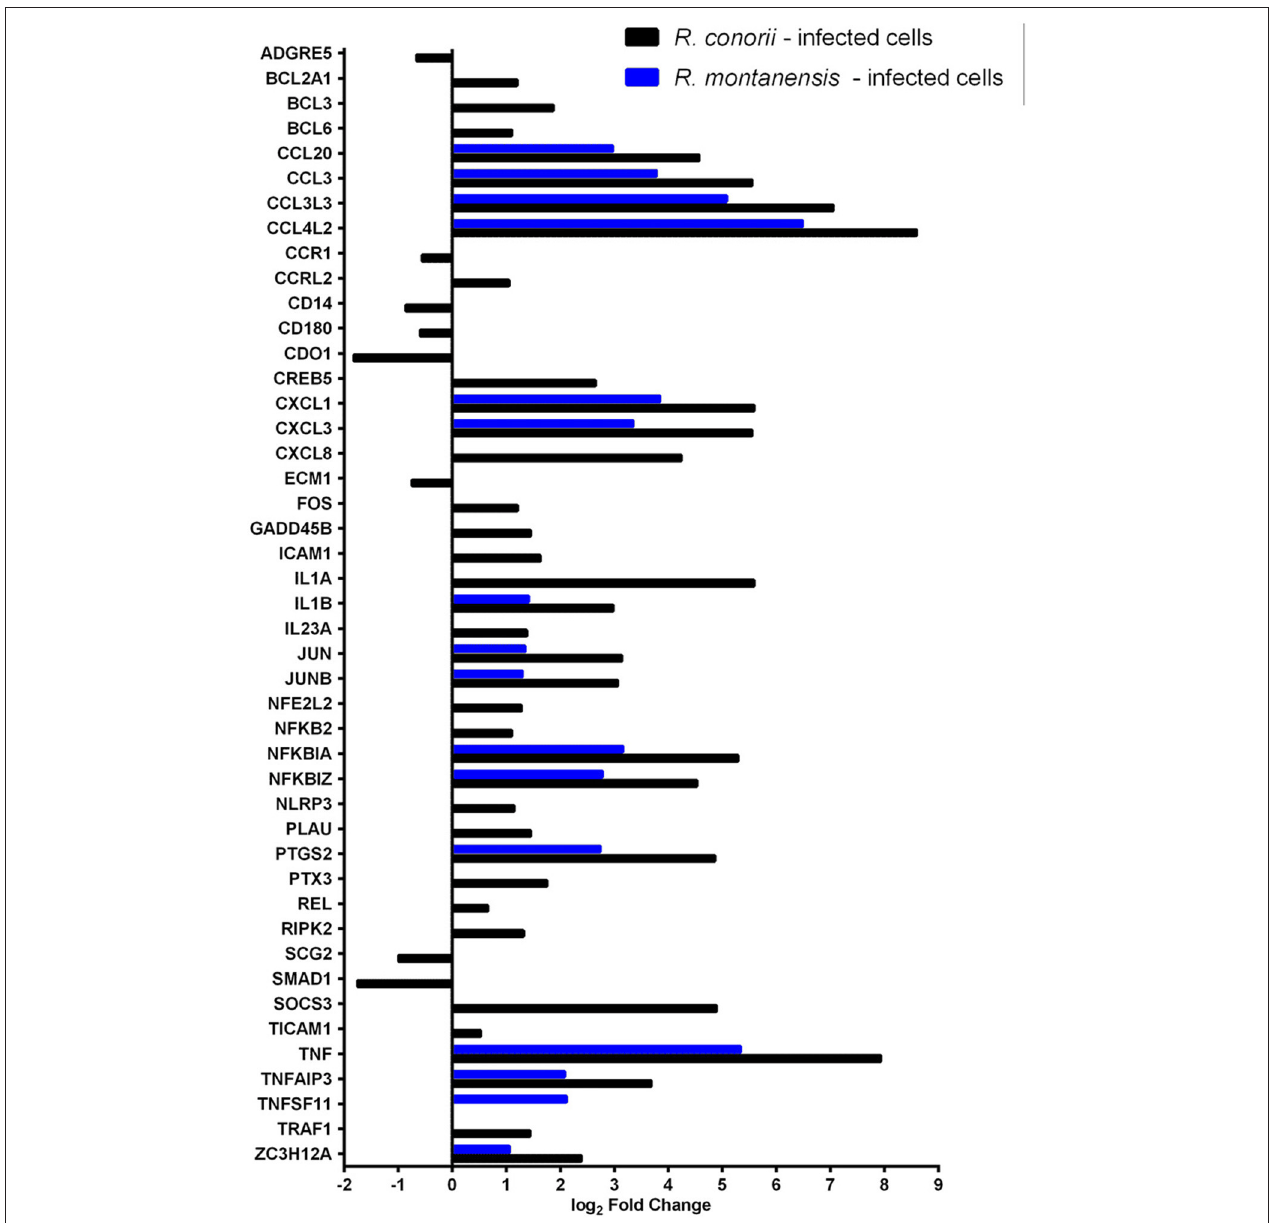
FIGURE 3 | Rickettsia conorii and R. montanensis differentially modulate innate immune responses during THP-1 macrophage infection. Combined list of the individual DE genes (and respective log 2 fold change values) categorized with the GO term inflammatory response (GO:0006954) and KEGG pathways: TLR signaling pathway (hsa04620), NF- κ B signaling pathway (hsa04064), and TNF signaling pathway (hsa04668). DE genes in THP-1 macrophages infected with R. conorii are shown in black bars and in R. montanensis are shown in blue. The absence of bar means that the fold change of that gene for the respective experimental condition was not considered statistically significant. See also Table S6